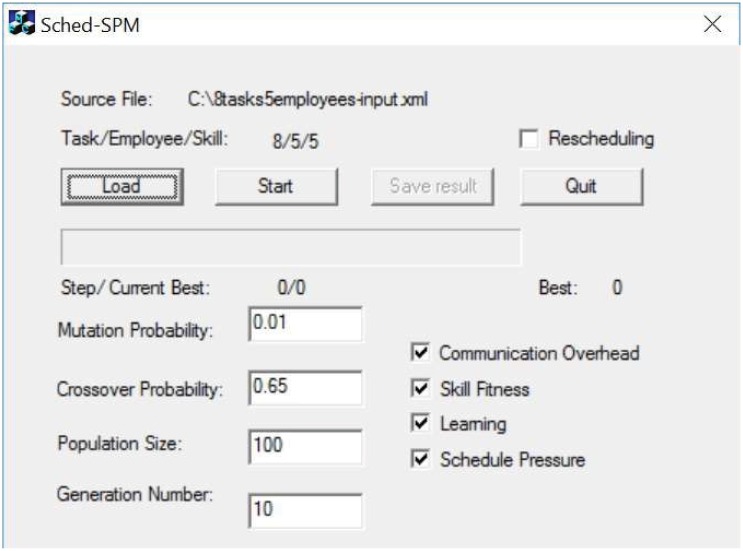
User Interface of Sched-SPM.